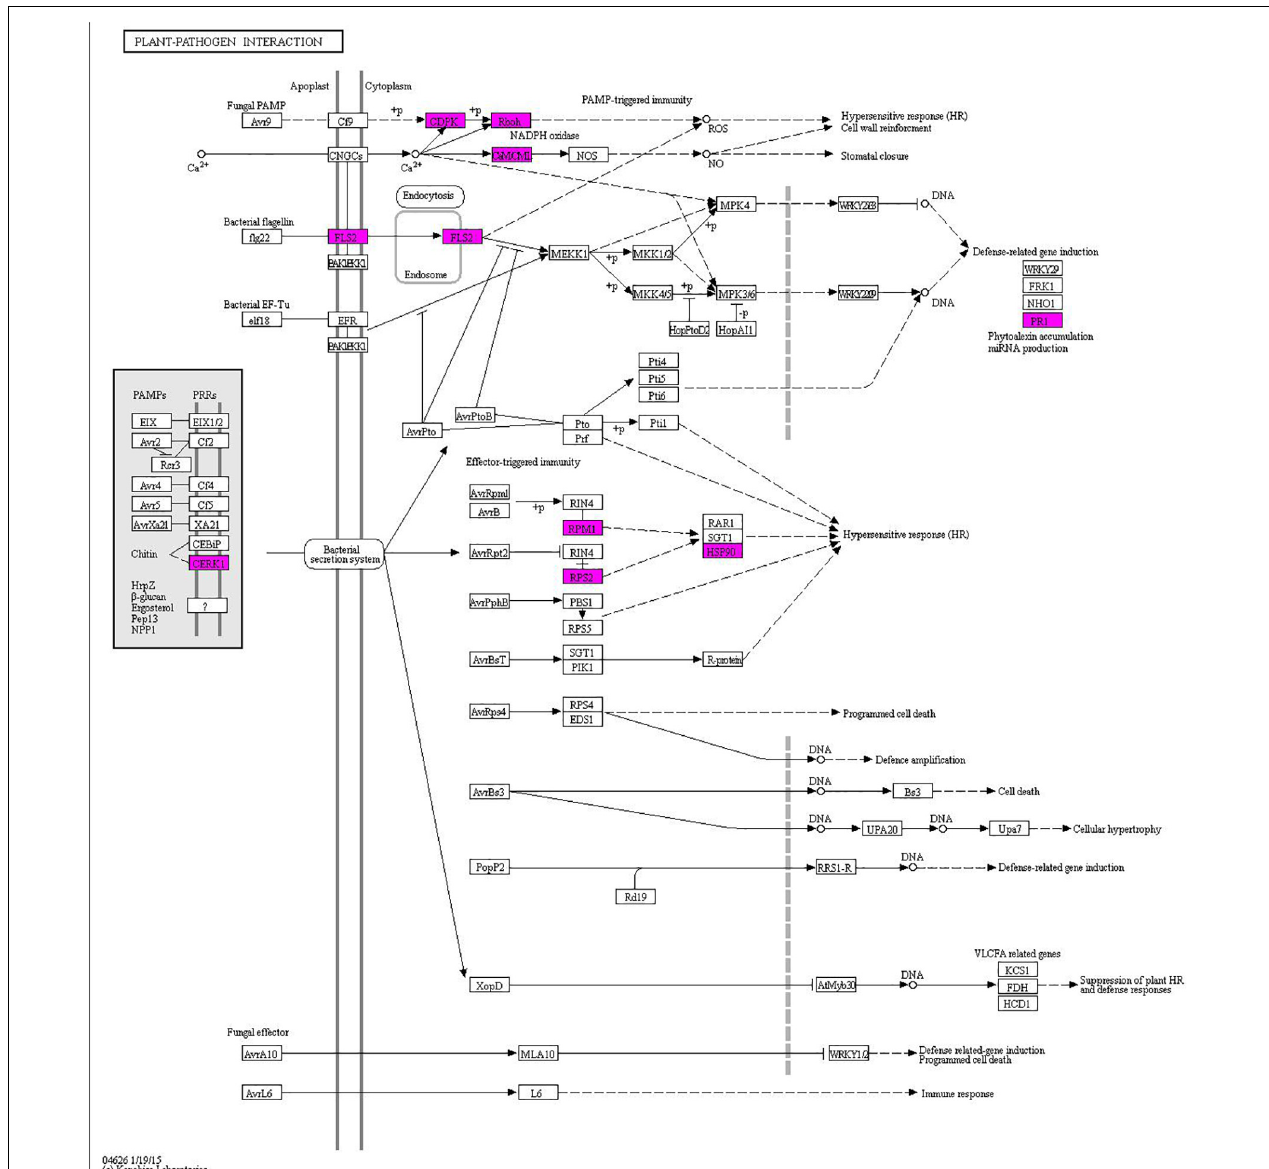
FIGURE 8 | The plant-pathogen interaction pathway enriched from DEGs with consistent differences between the resistance and susceptible parents YD588 and YN21 and their derived resistance and susceptible bulks from their derived F 2 : 3 families.